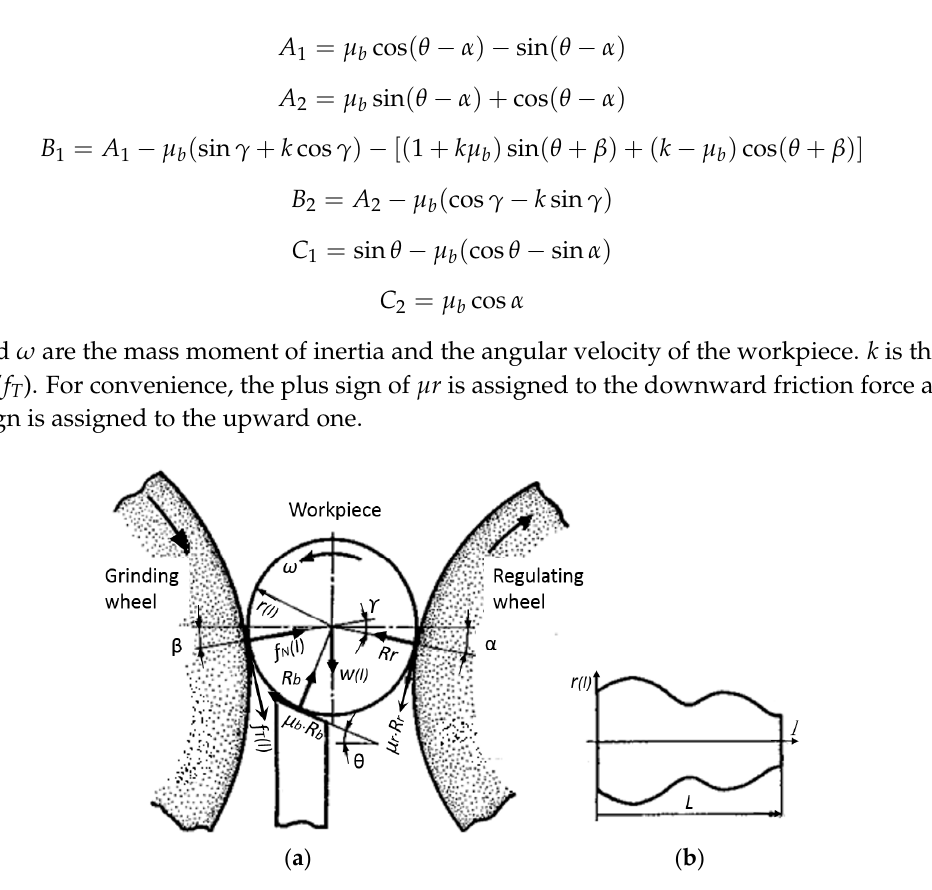
Figure 5. Arrangement of centerless grinding and forces acting on workpiece. ( a ) Forces acting on workpiece during centerless grinding; ( b ) Cylindrical workpiece.